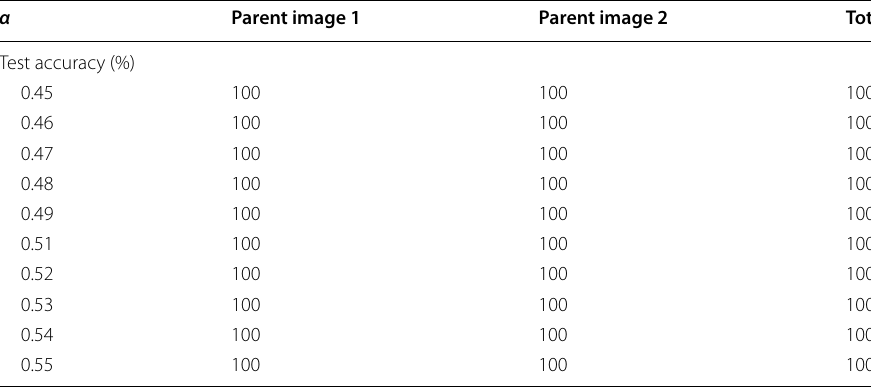
Table 4 Test results of MFR‑Net V1 with α between 0.45–0.55 (excluding 0.5)